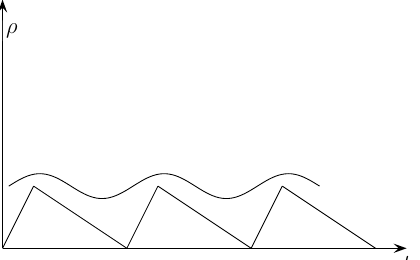
Figure 4: The sequential passing of solitons (sharp peaks) can be approximated by a sinusoidal wave